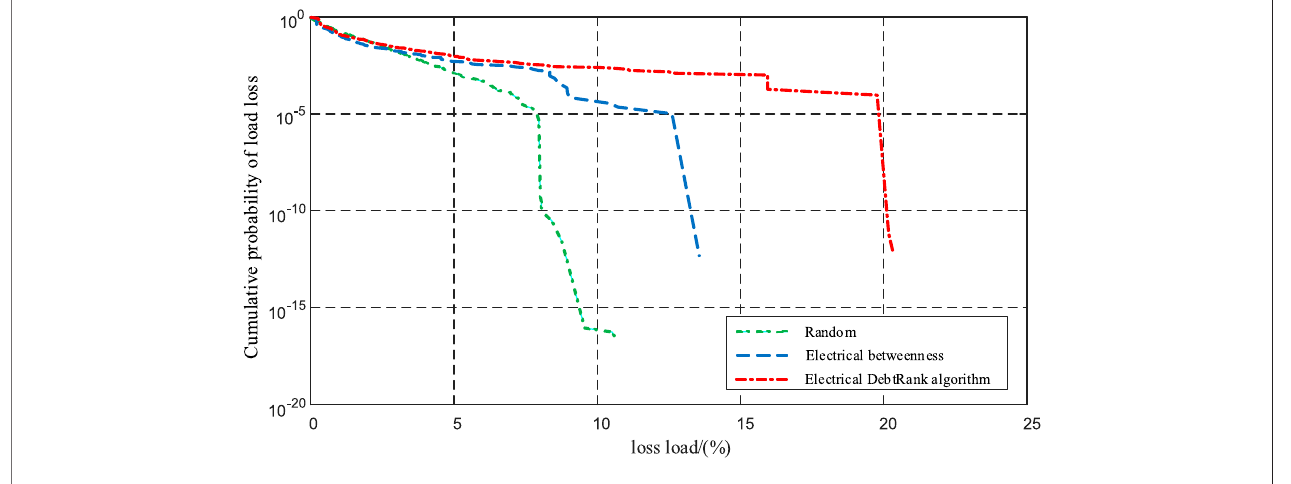
FIGURE 6 | IEEE-118 bus power system line fl uctuation load loss comparison.